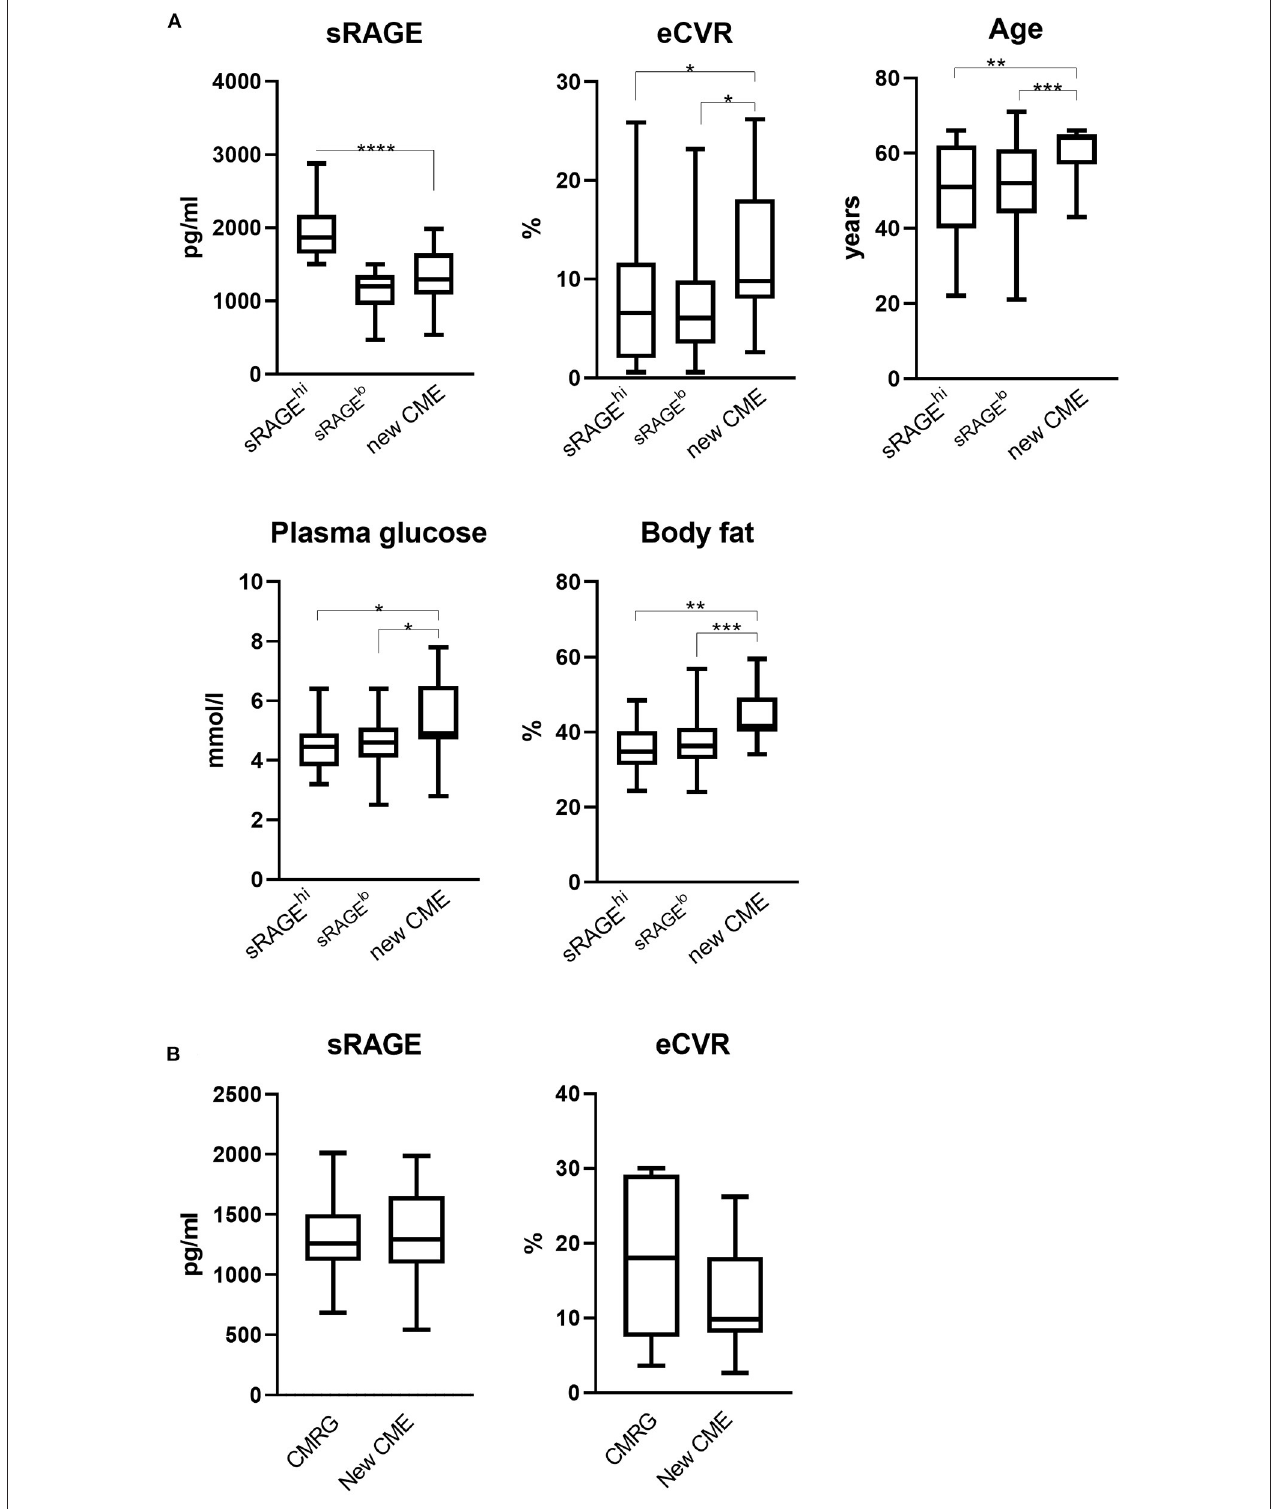
FIGURE 3 | (A) Comparison of metabolic and inflammation-related characteristics of RA patients with new cardiometabolic events. During the prospective follow up for 5 years, 11 of 171 patients developed new cardiometabolic events (CME). This group was compared to the patients with high (sRAGE hi , n = 69) and low (sRAGE lo , n = 91) serum levels of soluble RAGE. eCVR, estimated cardiovascular risk; RAGE, receptor for advanced glycation end products. (B) Comparison of new CME group ( n = 13) with CMR ( n = 11) group with respect to eCVR and sRAGE. *The comparison is done pairwise using the Mann-Whitney U -test. The box plots indicate medians and interquartile ranges; whiskers show min to max. * P < 0.05; ** P < 0.01; *** P < 0.001; and **** P < 0.0001.